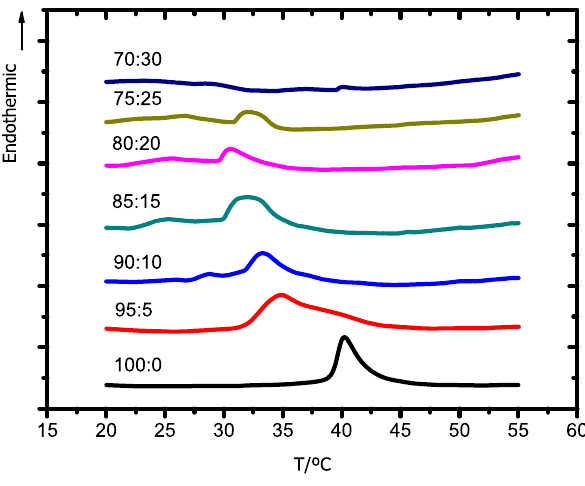
Figure 4. DSC thermograms of the DPPC:Chol:12-10-12 system for the lipid:surfactant molar ratios indicated. A scanning rate of 10 u C/min was used.